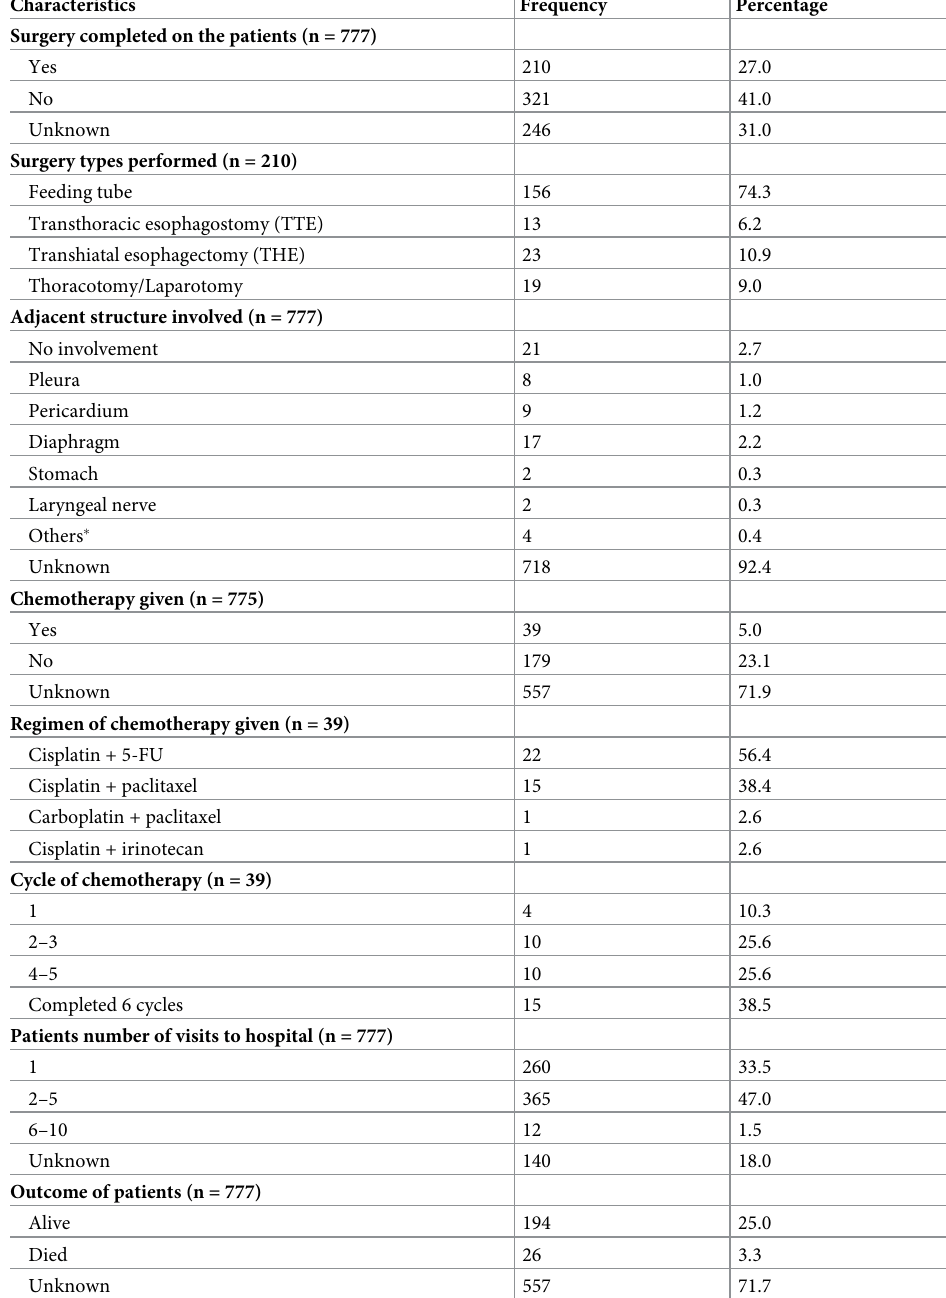
Table 3. Treatment pattern and outcome of Oesophageal cancer patients in selected hospitals, Ethiopia, 2018.